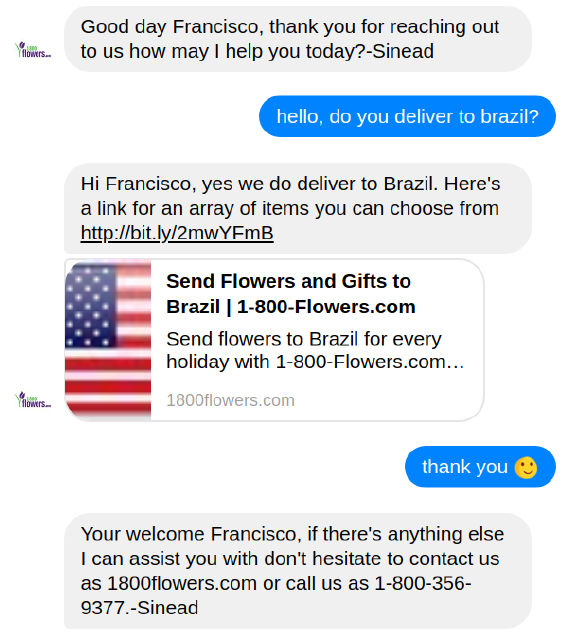
Fig. 23. Human beings sending messages thorough 1-800-Flowers.com